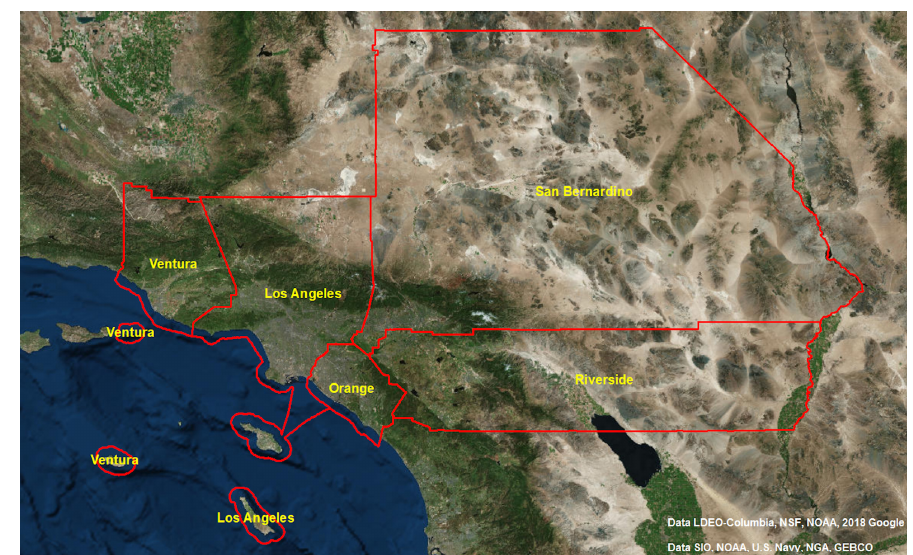
Figure 1. The Hestia-LA urban domain. © Google